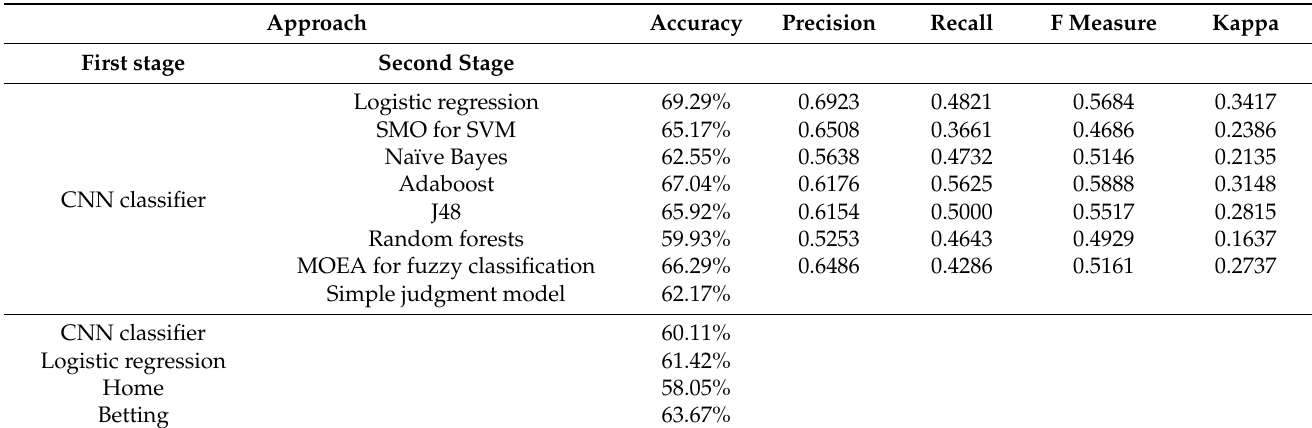
Table 2. Comparison of different approaches used in the judgment model. Approach Accuracy Precision Recall F